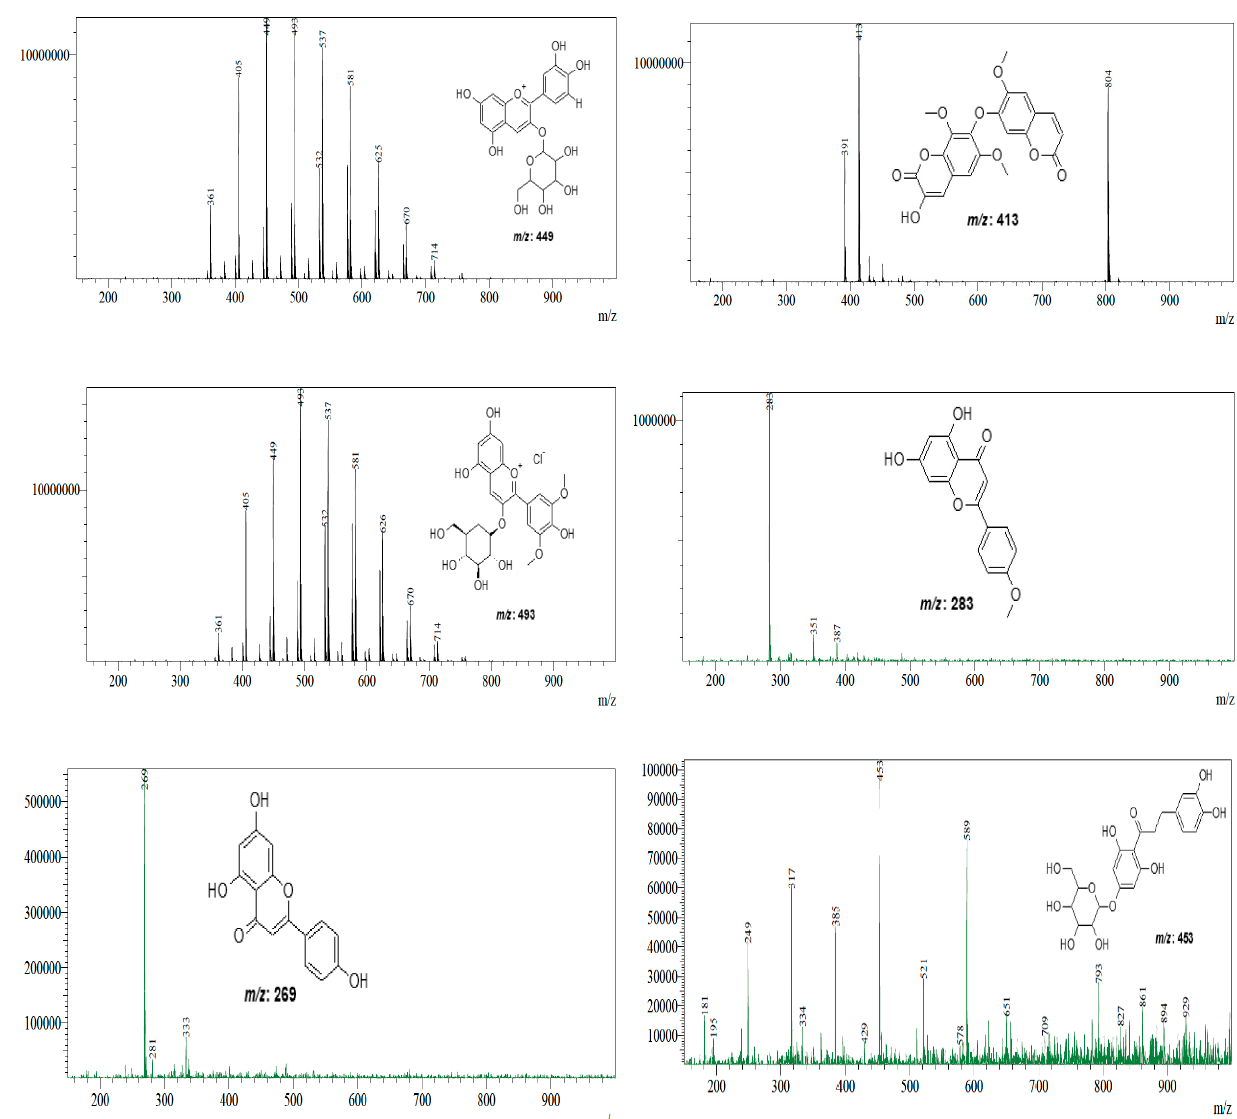
Figure 2. Mass spectra of detected compounds from A. campestris extracts.